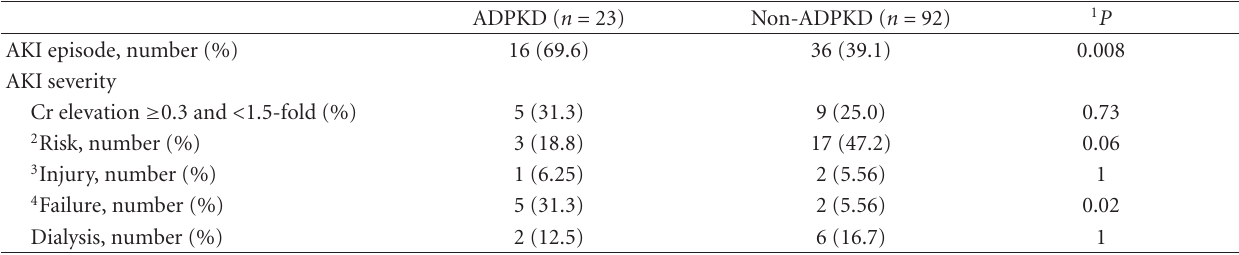
Table 2: AKI in pneumonia patients with and without ADPKD.